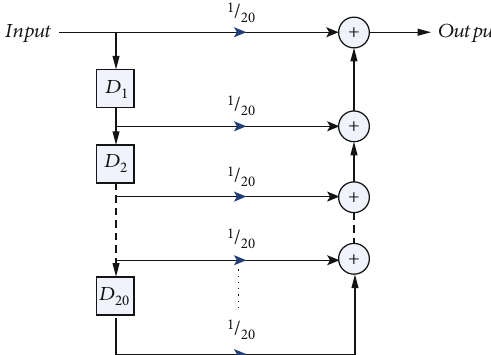
Figure 5: The moving average fi lter used as a low-pass fi lter for the raw sensor of the fi ltering process. The fi nal state propagates in discrete domain by χ = ϕχ + U + w , ð 1 Þ k k k k − 1 = ½ 0 0 T (cid:2) T and the plant is the state vector, U where χ k k